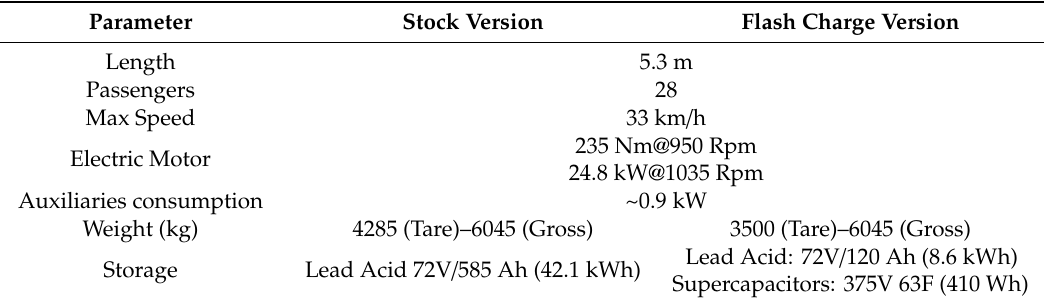
Table 1. Tecnobus Gulliver U500